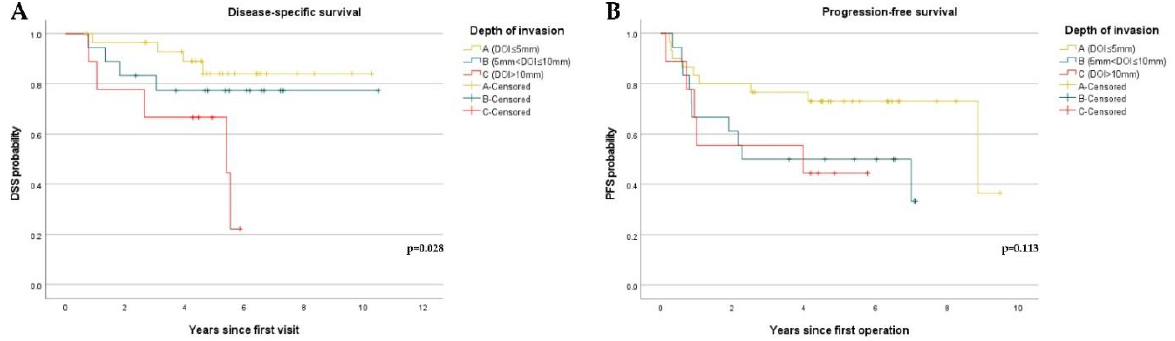
Figure 2. Kaplan–Meier curves showing disease-specific survival (DSS) and progression-free survival (PFS) stratified by depth of invasion (DOI): ( A ) DSS curves stratified by DOI. (A [DOI ≤ 5 mm], n = 30, B [5 mm < DOI ≤ 10 mm], n = 18, C [DOI > 10 mm], n = 9); ( B ) PFS curves stratified by DOI. (A [DOI ≤ 5 mm], n = 30, B [5 mm < DOI ≤ 10 mm], n = 18, C [DOI > 10 mm], n = 9). Figure 3. Kaplan – Meier curves showing disease-specific survival (DSS) and progression-free survival (PFS) stratified by tumor thickness (TT): ( A ) DSS curves stratified by TT. (A [TT ≤ 5 mm], n = 19, B [5 mm < TT ≤ 10 mm], n = 28, C [TT > 10 mm], n = 10); ( B ) PFS curves stratified by TT. (A [TT ≤ 5 mm], n = 19, B [5 mm < TT ≤ 10 mm], n = 28, C [TT > 10 mm], n = 10). Figure 4. Kaplan – Meier curves showing disease-specific survival (DSS) and progression-free survival (PFS) stratified by the T category of the 7th edition of the AJCC system: ( A ) DSS curves stratified by the T category based on the 7th edition of the AJCC. (T1, n = 35, T2, n = 22); ( B ) PFS curves stratified by T category based on the 7th edition of AJCC. (T1, n = 35, T2, n = 22).